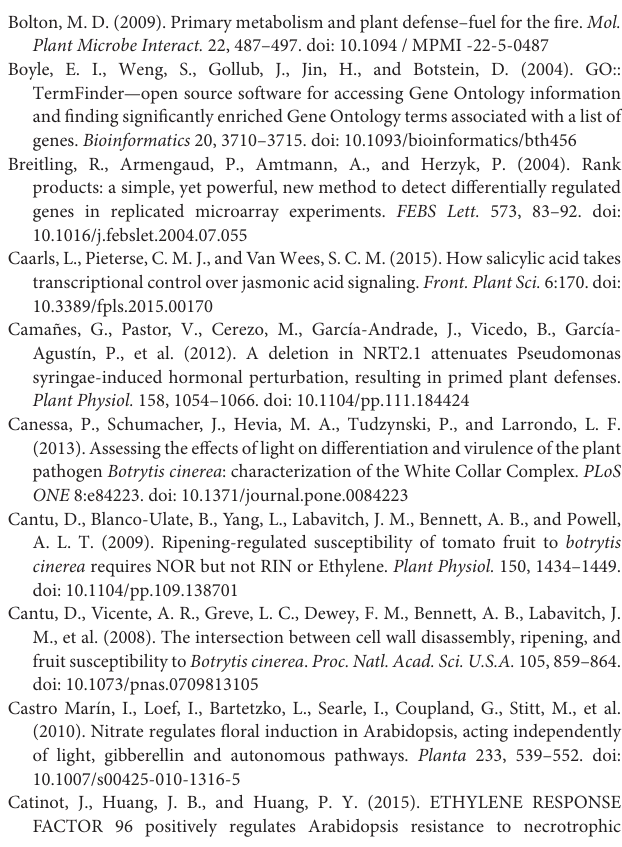
Table S3 | Microarray expression data for genes that are either up- or down-regulated by the B. cinerea infection in comparison to mock-inoculated plants grown in N- sufficient conditions (6mM nitrate) (ANOVA; Rank-products, p < 0.05 ). The table includes the Affymetrix probes, the tomato accessions (ITAG2.4, Sol Genomics Network, https://solgenomics.net) and their annotations, Arabidopsis (TAIR, http://arabidopsis.org) or GeneBank accessions, the p -value, Gene Ontology and the log2-fold changes of the comparison between B. cinerea infected and mock-treated sample (B/M) grown in N-sufficient conditions (6mM nitrate). Table S4 | Microarray expression data for genes that are either up- or down-regulated by the B. cinerea infection in comparison to mock-inoculated plants grown in N- sufficient conditions (12mM nitrate) (ANOVA; Rank-products, p < 0.05 ). The table includes the Affymetrix probes, the tomato accessions (ITAG2.4, Sol Genomics Network, https://solgenomics.net) and their annotations, Arabidopsis (TAIR, http://arabidopsis.org) or GeneBank accessions, the p -value, Gene Ontology, and the log2-fold changes of the comparison between B. cinerea infected and mock-treated sample (B/M) grown in N-limiting sufficient (12mM nitrate). Table S5 | Candidate TF used for RT-qPCR analysis. The table includes the Arabidopsis (TAIR, http://arabidopsis.org) and the tomato accessions (Sol Genomics Network, https://solgenomics.net), the gene names, the module in network analysis and changes in relative expression (log2) between infected and Table S6 | Primer sequences used for qPCR. Data Sheet S1 | Gene network in